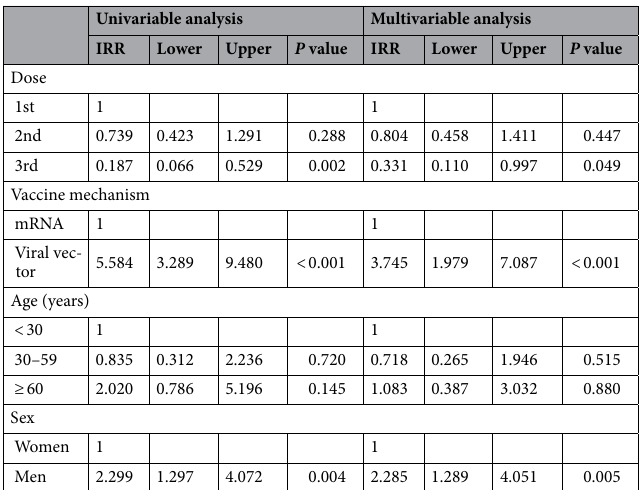
Table 1. Incidence rate ratios for SARS-CoV-2 vaccination and GBS following vaccination. IRR incidence rate ratio.